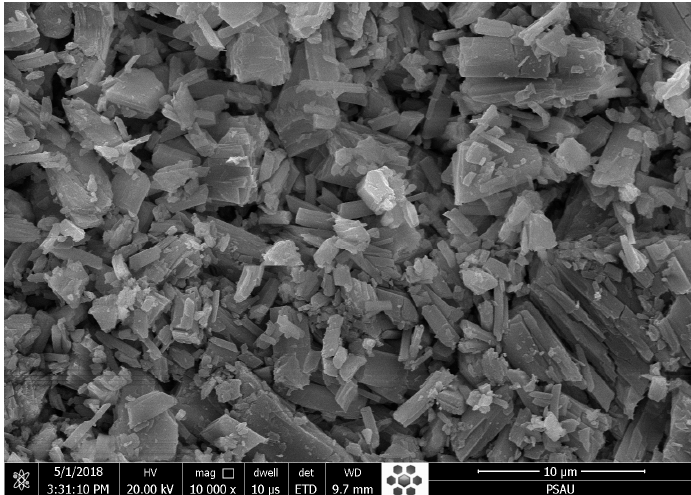
Figure 2. SEM image of marble paste (×10,000).